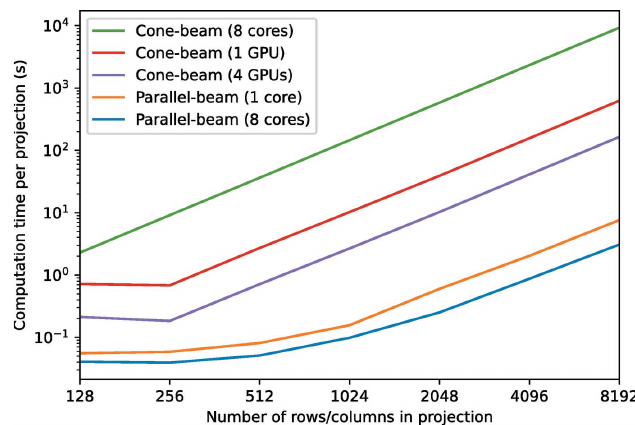
Figure 11 The required computation time for generating a tomographic projection for a phantom with 150000 voids as a function of the number of detector rows and columns. Results are given for using a single CPU core, eight CPU cores, a single GPU, and four